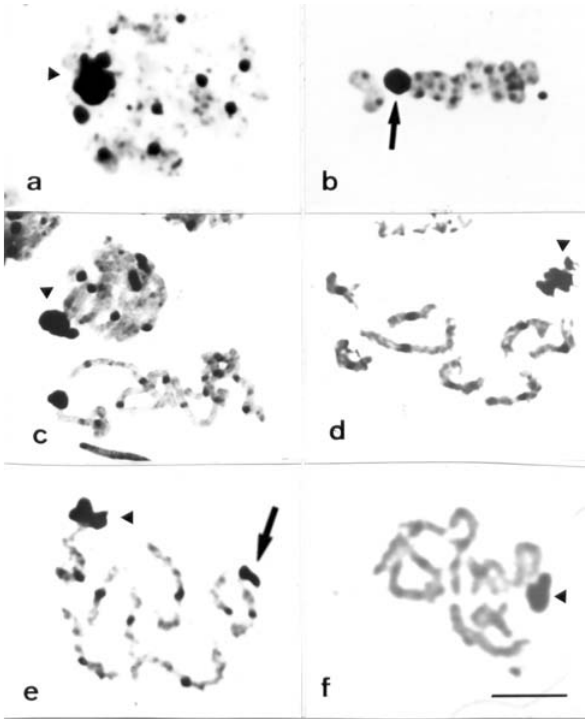
Figure 4 - Silver nitrate staining in the five species analyzed. Pachytene and metaphase I of G. borelli (a, b). Zygotene and initial pachytene of P. pallidipennis (c). Final pachytene of M. festiva (d). Pachytenes of L. ebenus (e) and S. s hirtus (f). Observe the heterochromatic regions and the strongly silver-labeled sex pair (b). The arrows in (b,e) indicate de Xy p bi- valent.Thearrowheadsindicatenucleolarorganizerregions.Bar=5 (cid:1) m.